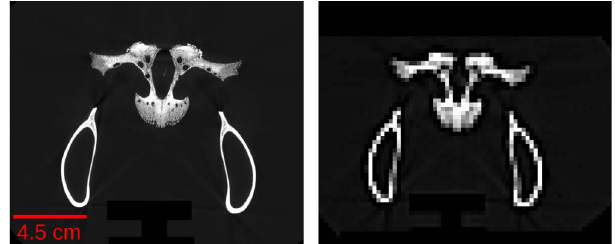
Figure 2. Three slices of dolphin ’ s skull, where we de fi ne the trabecular and cortical bones.